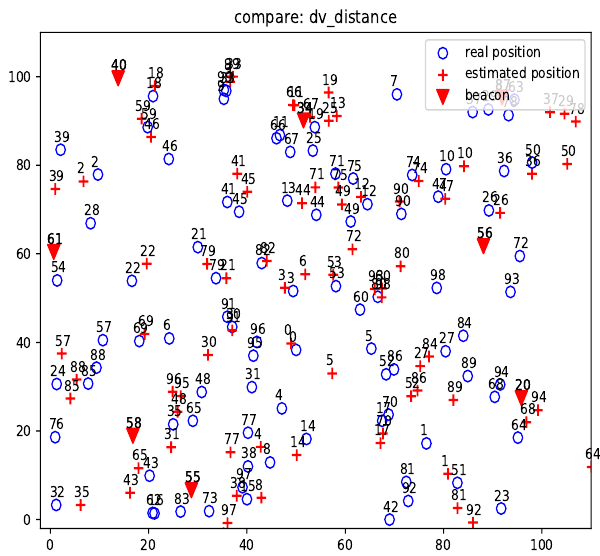
Figure 10. DV-distance result for the projected 100-node 9-beacon MUWSN on the beacon plane in E 2 .